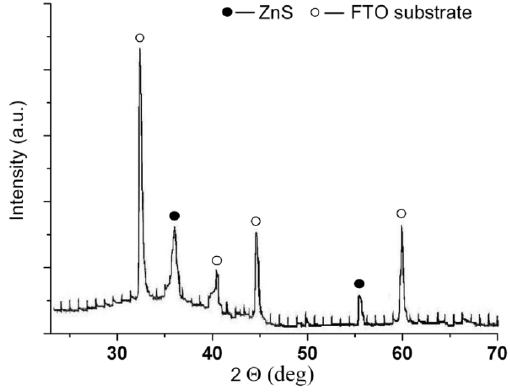
Figure 5. X ‐ ray spectra of electrodeposited ZnS film. Figure 5. X-ray spectra of electrodeposited ZnS